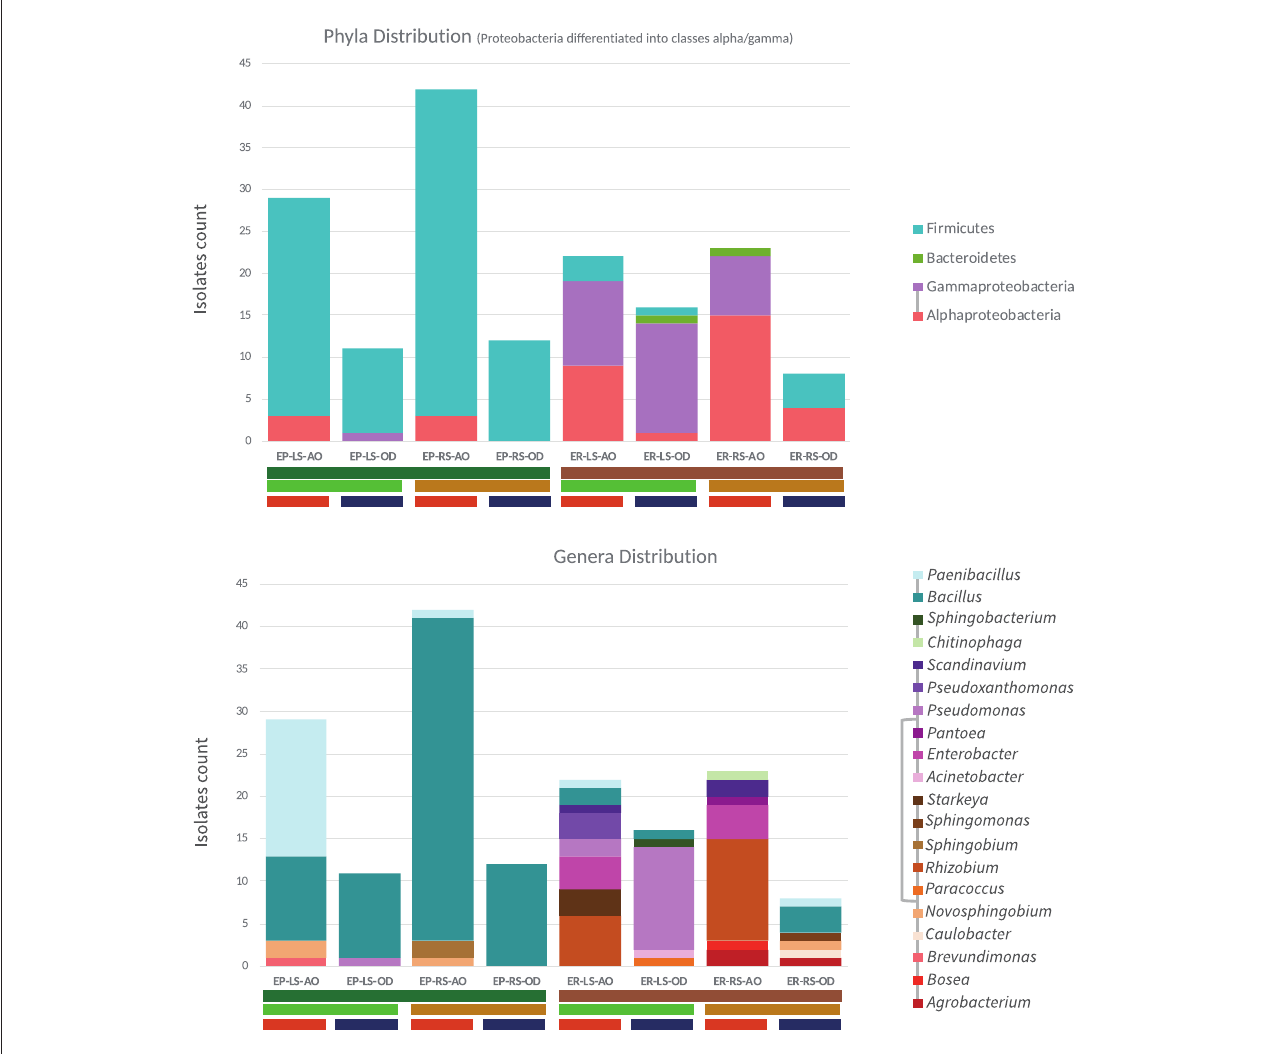
FIGURE 6 | Based on 16S rRNA gene sequences, the taxonomic status of endo-phyllosphere (EP) and endo-rhizosphere (ER) bacterial isolates enriched on leaf strips (LS) and root segments (RS) based culture media under ambient (AO) and limited oxygen (OD) conditions. Respective isolate counts are shown on phylum and genus levels. The phyla affiliation of each genus is indicated by the phyla-specific coloring and connected lines in the legend.